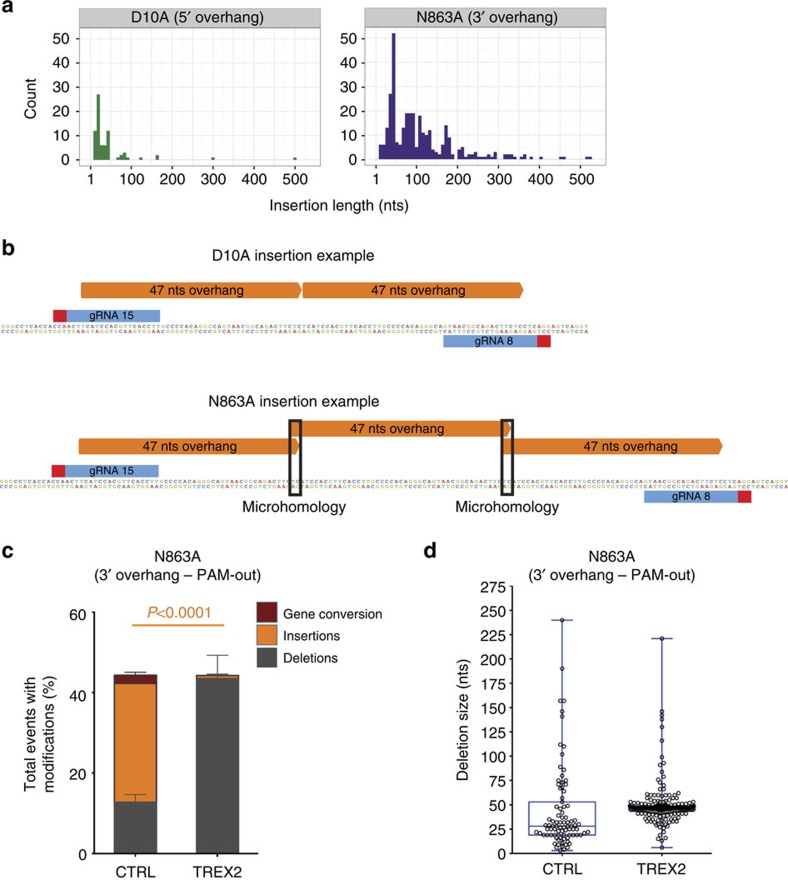
Characterization of insertions deriving from the D10A and N863A Cas9 variants using gRNA pair 8/15 in PAM-out orientation.(a) Histogram plot of insertion length for the D10A Cas9 (green) and N863A Cas9 (purple)-induced insertions. Individual insertion size data from each Cas9 variant was scored from Sanger sequencing data of U2OS cells treated with either D10A or N863A Cas9 and gRNA pair 8/15. Difference in length between D10A and N863A-induced insertions is significant: P=1.274 × 10−12 (permutation test). Number of insertions plotted is 75 for D10A and 325 for N863A. (b) Example of insertions of the full overhang resulting from N863A and D10A Cas9-induced lesions. Insertions (indicated as filled orange arrows) induced from D10A Cas9 do not show overlap while those from N863A Cas9 do indicating microhomology usage in the latter case (indicated in black box). Position of gRNA indicated in blue, with red box representing the PAM. (c) Overall modification frequency resolved for deletions, insertions and gene conversion scored by Sanger sequencing of the amplified HBB locus in U2OS cells expressing the N863A Cas9 variant and gRNA pair 8/15 in the presence (TREX2) or absence (CTRL) of TREX2. The P value for the difference in insertion frequency was calculated using the two-tailed Student's t-test. Data are represented as mean±s.e.m. The total number of sequences plotted from six independent experiments is 684 for CTRL and 672 for TREX2-expressing cells. (d) Scatter dot plot overlaid with a box and whisker plot representing the deletions size scored from Sanger sequencing data of U2SOS cells expressing the N863A Cas9 variant with gRNA pair 8/15 in the presence (TREX2) or absence (CTRL) of TREX2. Each individual dot represents one Sanger sequenced read harbouring a deletion. The total number of sequences plotted from six independent experiments is 87 for control and 264 for TREX2-expressing cells. The line within the box depicts the median, with the box extending from the 25th to the 75th percentiles. The whiskers depict the minimum and maximum values of the data set.